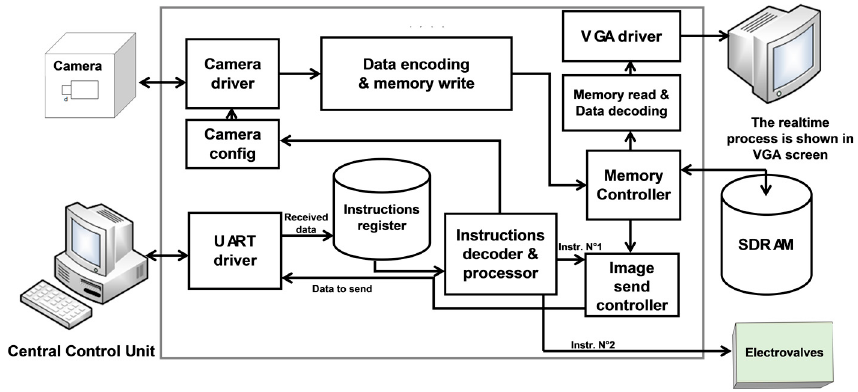
Figure 6. The devised Front End Embedded System (FEES) architecture.